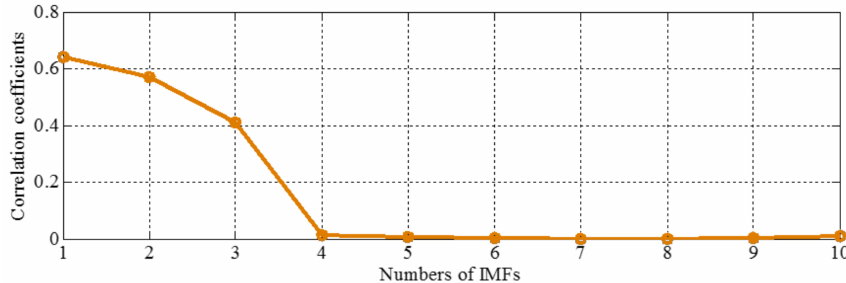
Figure 9. The coefficients of correlation between different IMFs and the sample signal f sig 2